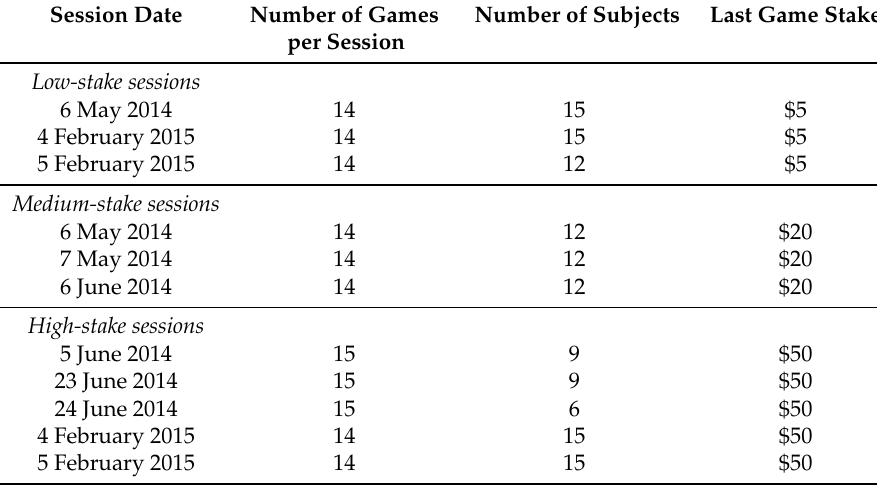
Table 1. Summary of experimental